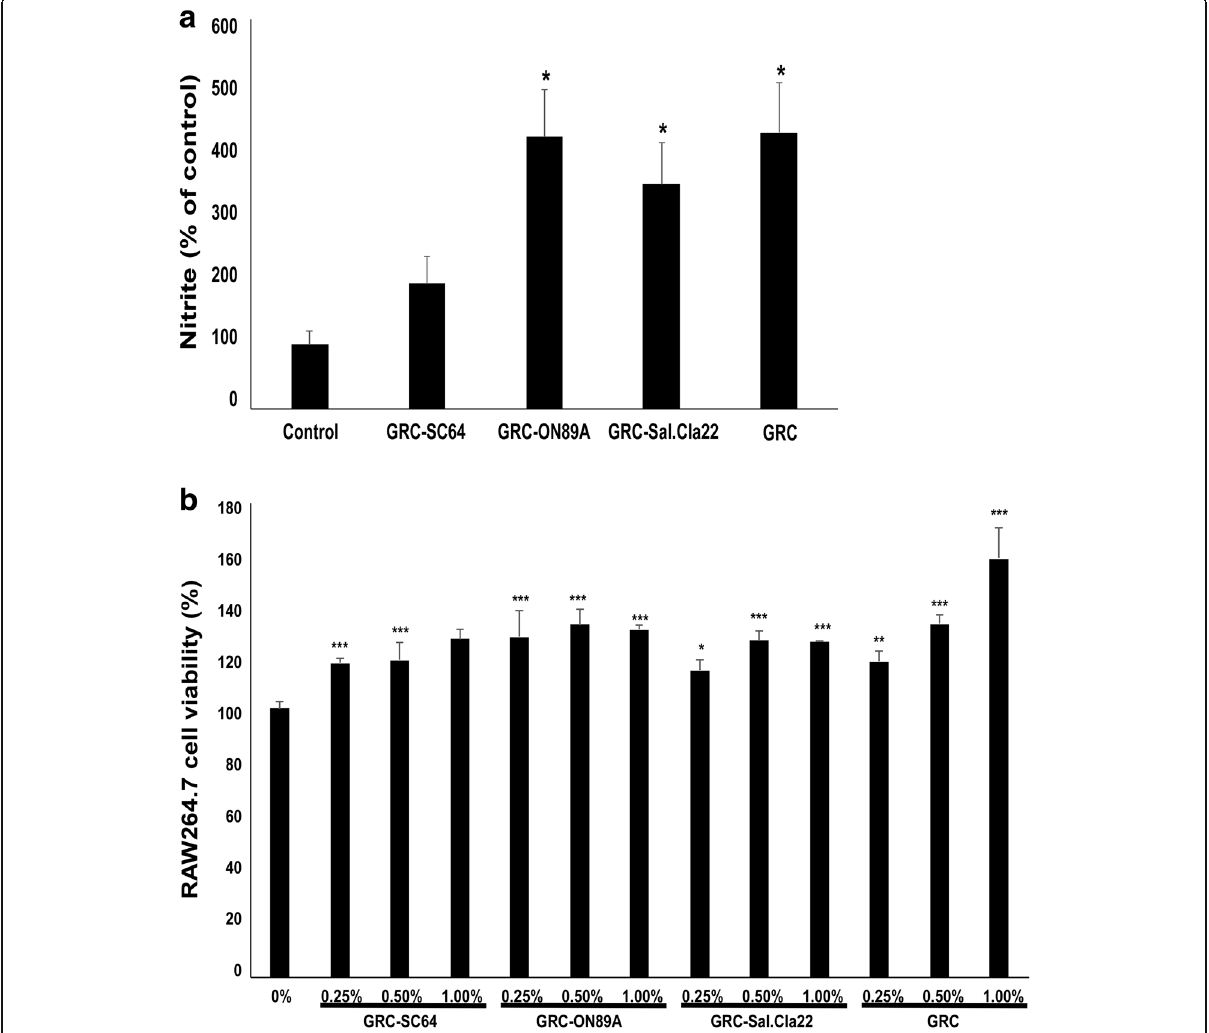
Fig. 1 Effects of GRC fermented with different probiotic stains on nitric oxide (NO) production. a RAW 264.7 cells were treated with GRC-SC64, GRC-ON89A, GRC-Sal.Cla22, or GRC. Nitrite levels in the culture media were determined using Griess reagent and were presumed to reflect NO levels. b RAW 264.7 cells were treated with various concentrations (0.25%, 0.50%, and 1.00%) of SC64, ON89A, Sal.Cla22, or GRC for 24 h. RAW 264.7 cell proliferation was assessed using a CCK-8 assay. One-way ANOVA was used for comparison of group means, followed by Dunnett ’ s t -test (* = p < 0.05, ** = p < 0.01, *** = p < 0.005 vs. control group). Each figure is representative of three independent